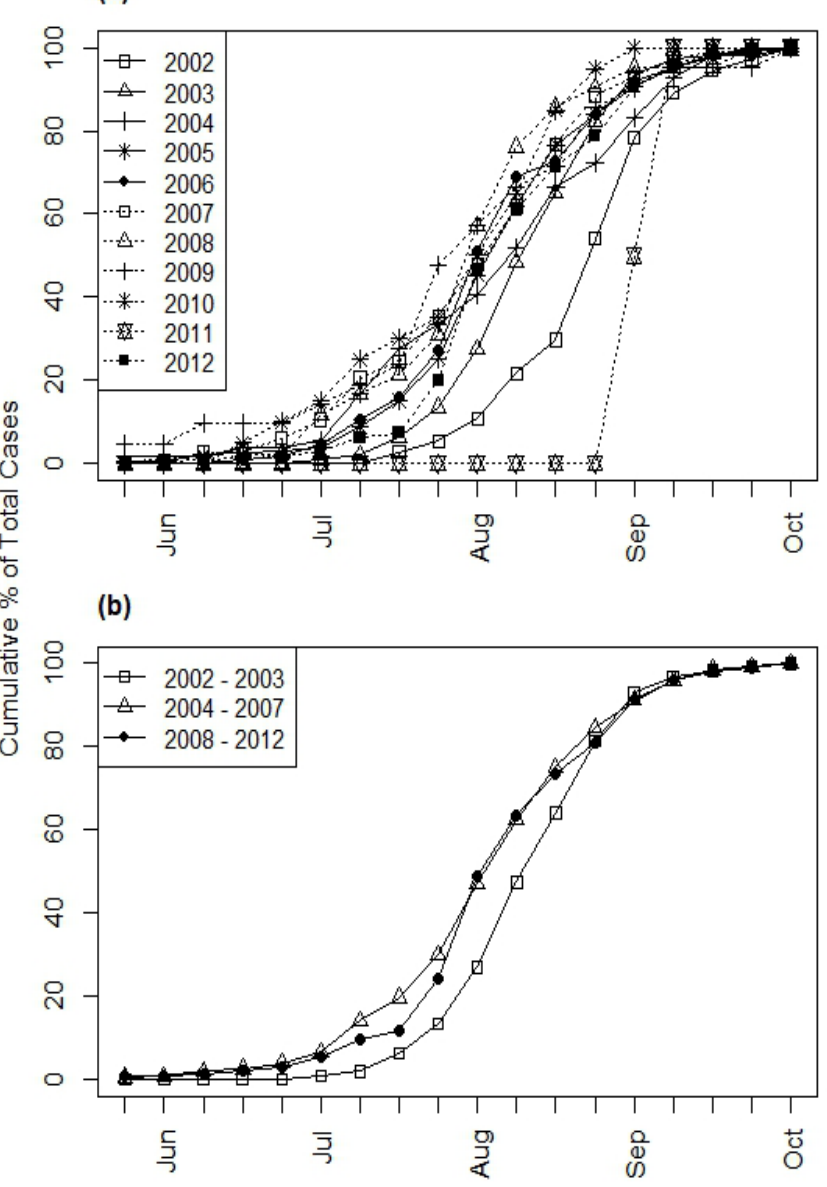
Figure 5. Weekly cumulative distributions of illness onsets of all human WNV cases (including both fever and neuroinvasive disease) in South Dakota from 2002–2012. ( a ) Annual curves, ( b ) Combined curves for three time